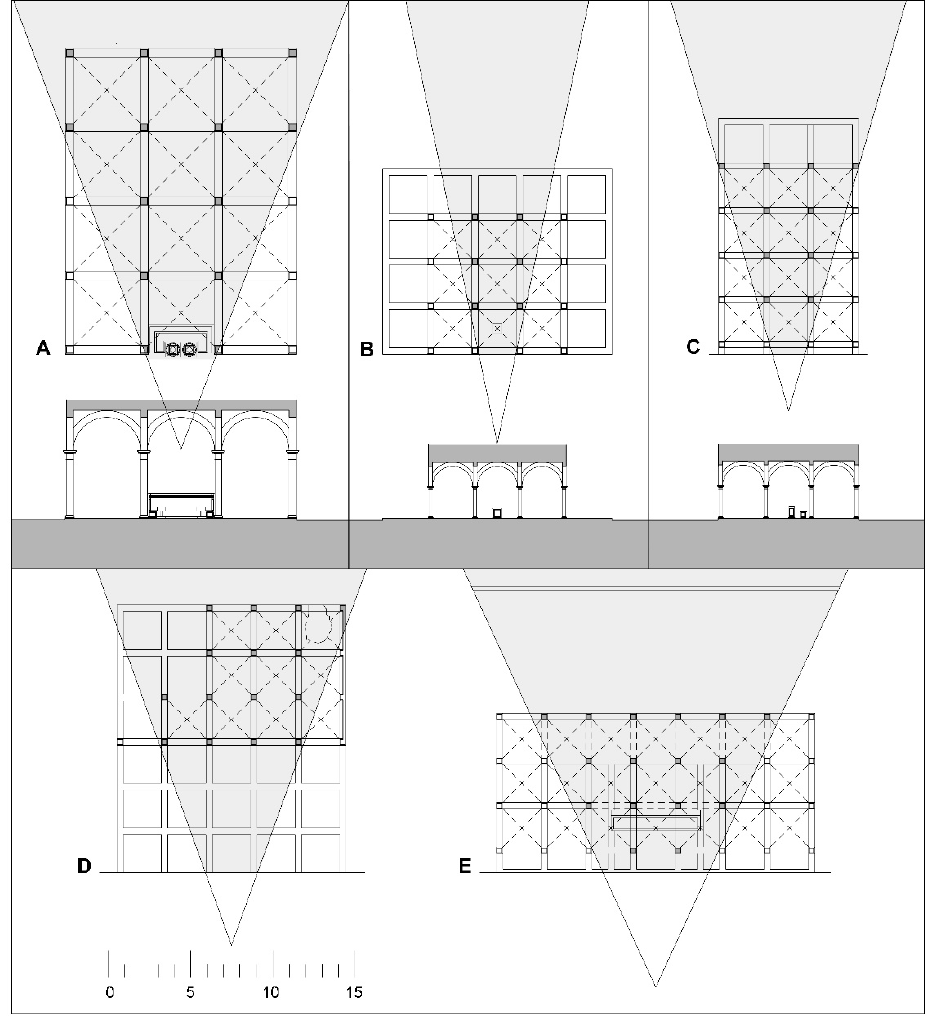
Figure 10. Perspective restitution in plan and section with the visual cones from Perugino’s works: ( A ). The Last Supper of St. Onofrio, Florence; ( B ). The Annunciation of Fano; ( C ). The Vision of St. Bernard; ( D ). The Nativity of Albani-Torlonia Polyptic; ( E ). The Wedding at Cana in St. Augustin.